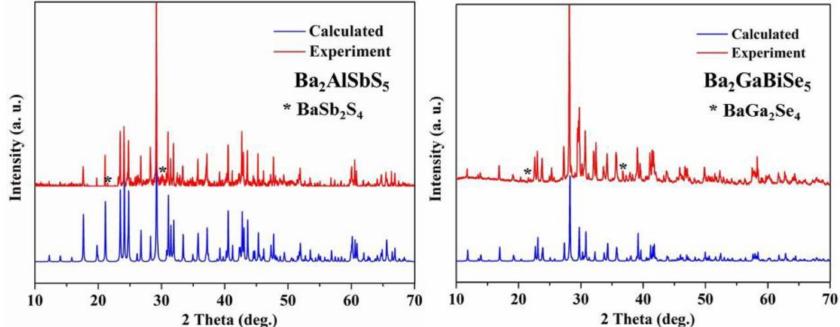
Figure 1. Powder XRD patterns of title